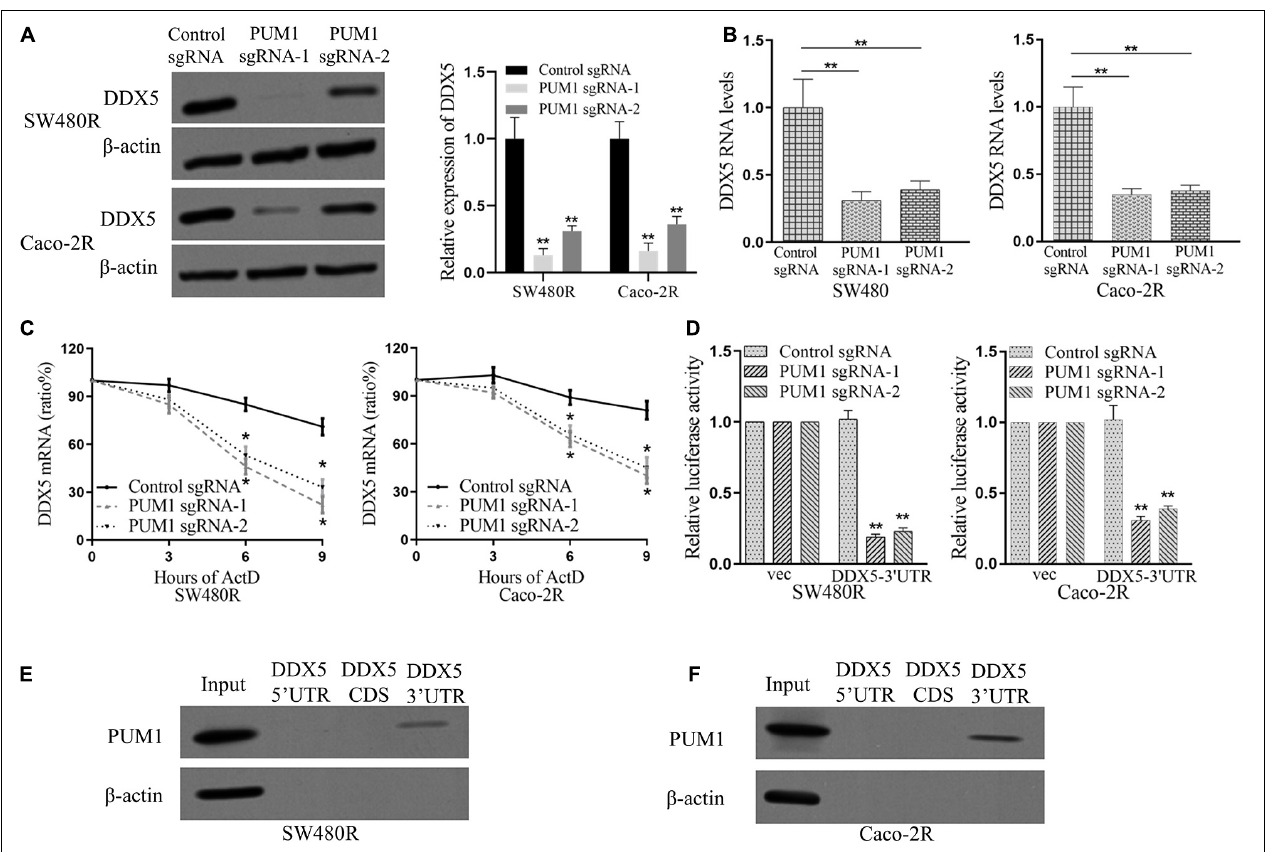
FIGURE 3 | Pumilio RNA-binding family member 1 (PUM1) positively regulates DEAD-box helicase 5 (DDX5) mRNA expression through DDX5 3 (cid:48) untranslated region (UTR). (A) Western blotting analysis of DDX5 proteins in both PUM1-deleted SW480R and Caco-2R cells. (B) β -actin was used as a loading control. Relative quantities of DDX5 mRNAs, extracted from sgRNA-control and PUM1-KO cells, were estimated using qRT-PCR. (C) Glyceraldehyde 3-phosphate dehydrogenase (GAPDH) serves as a control. The mRNA decay rate of DDX5 as indicated in SW480R and Caco-2R cells by qRT-PCR after suppressing PUM1 expression followed by actinomycin D treatment (10 mg/ml) for specified time points. (D) GAPDH serves as a control. Dual-luciferase assays showing the luciferase of DDX5 3 (cid:48) UTR following PUM1-KO. The empty 3 (cid:48) UTR luciferase plasmid served as a loading control. Synthetic RNA oligos with the indicated PUM1 consensus sequences for DDX5 were examined through RNA pull-down and blotted for PUM1 in (E) SW480R and (F) Caco-2R cells. Data are mean ± SD of three independent experiments, and each was measured in triplicate. * p < 0.05, ** p <